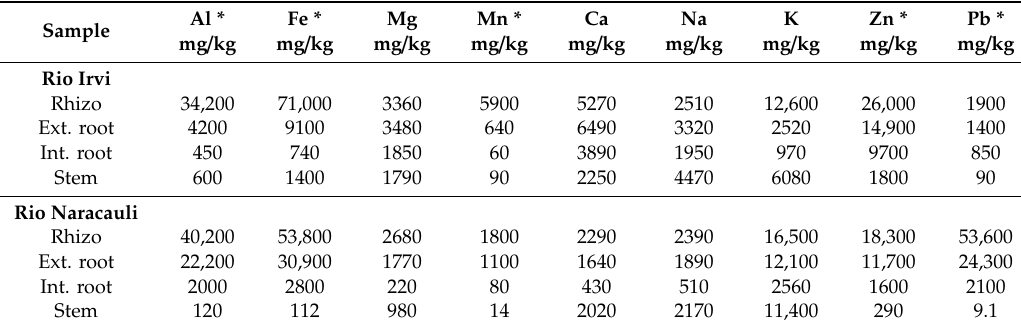
Table 1. Chemical analysis of selected major and minor elements of collected samples. * indicates data reported from Medas et al.